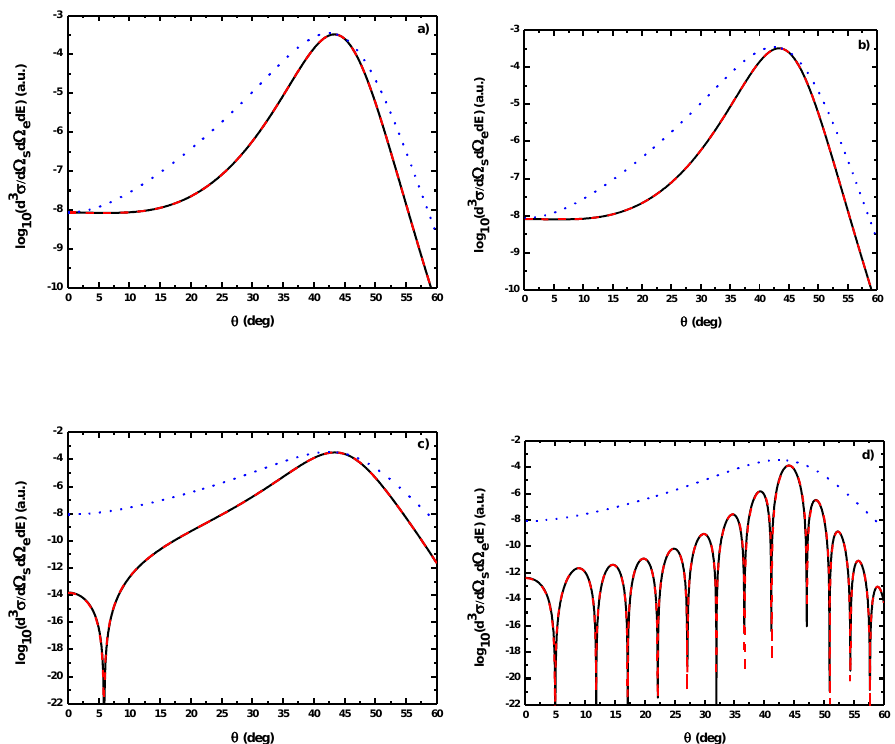
Figure 19. (Color online) Triple differential cross sections corresponding to laser-assisted electron-impact ionization of atomic hydrogen in the ground state for the case of a coplanar symmetric geometry as a function of the scattering angle θ = θ s = θ e with no net exchange of photons ( (cid:96) = 0). = 500 eV, and the laser photon energy is ω = 1.17 eV. The laser The incident electron energy is E k i polarization vector is taken to be parallel to the momentum transfer ∆ . Solid lines: First Born approximation results; dashed line: results obtained by neglecting the dressing of the target by the laser field; dotted lines: field-free results. ( a ) The electric field strength is E 0 = 10 5 V/cm which corresponds to a laser beam intensity of I = 1.32 × 10 7 W/cm 2 ; ( b ) E 0 = 10 6 V/cm ( I = 1.32 × 10 9 W/cm 2 ); ( c ) E 0 = 10 7 V/cm ( I = 1.32 × 10 11 W/cm 2 ) and ( d ) E 0 = 10 8 V/cm ( I = 1.32 × 10 13 W/cm 2